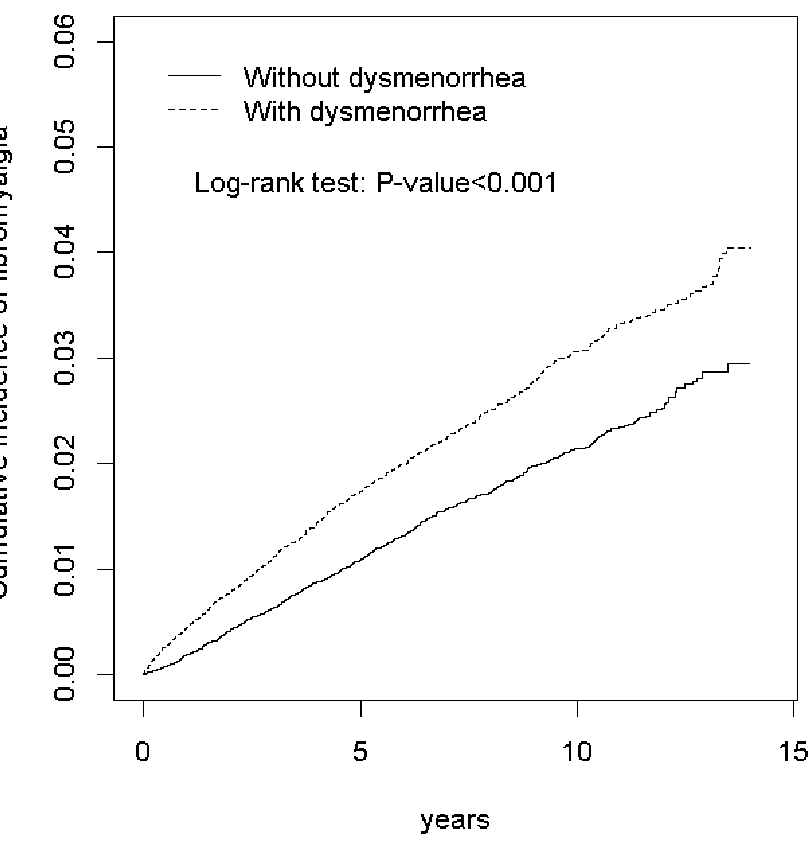
Figure 1. Cumulative incidence comparison of fibromyalgia for patients with (dashed line) or without (solid line) dysmenorrhea. Table 3. Incidence and hazard ratio of fibromyalgia for patients with or without dysmenorrhea. Dysmenorrhea to Non-Dysmenorrhea Dysmenorrhea